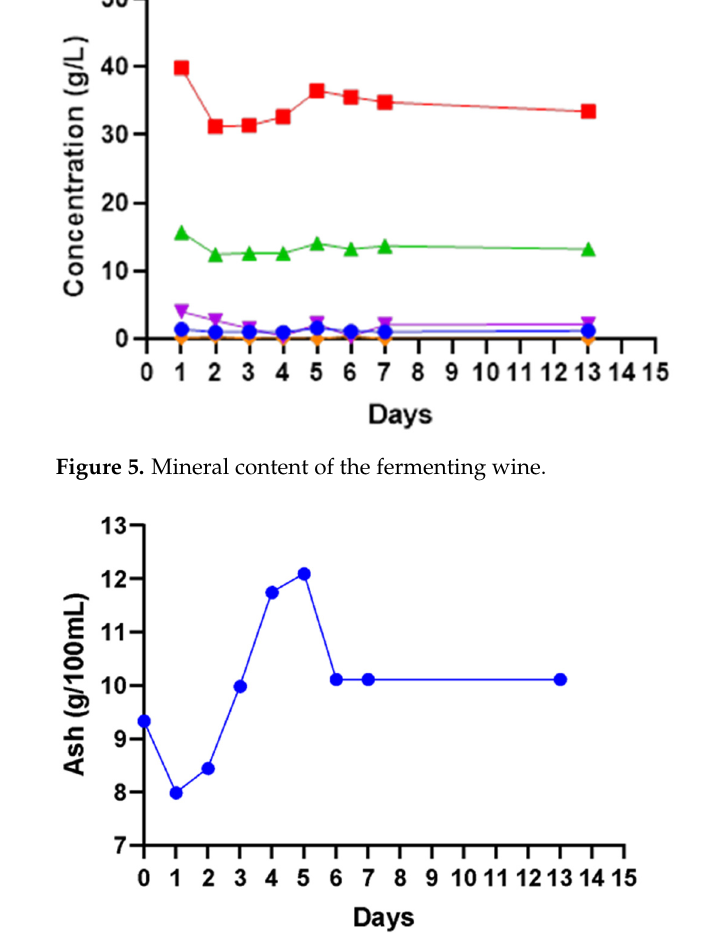
Figure 6. Change in ash content during fermentation of the wine.